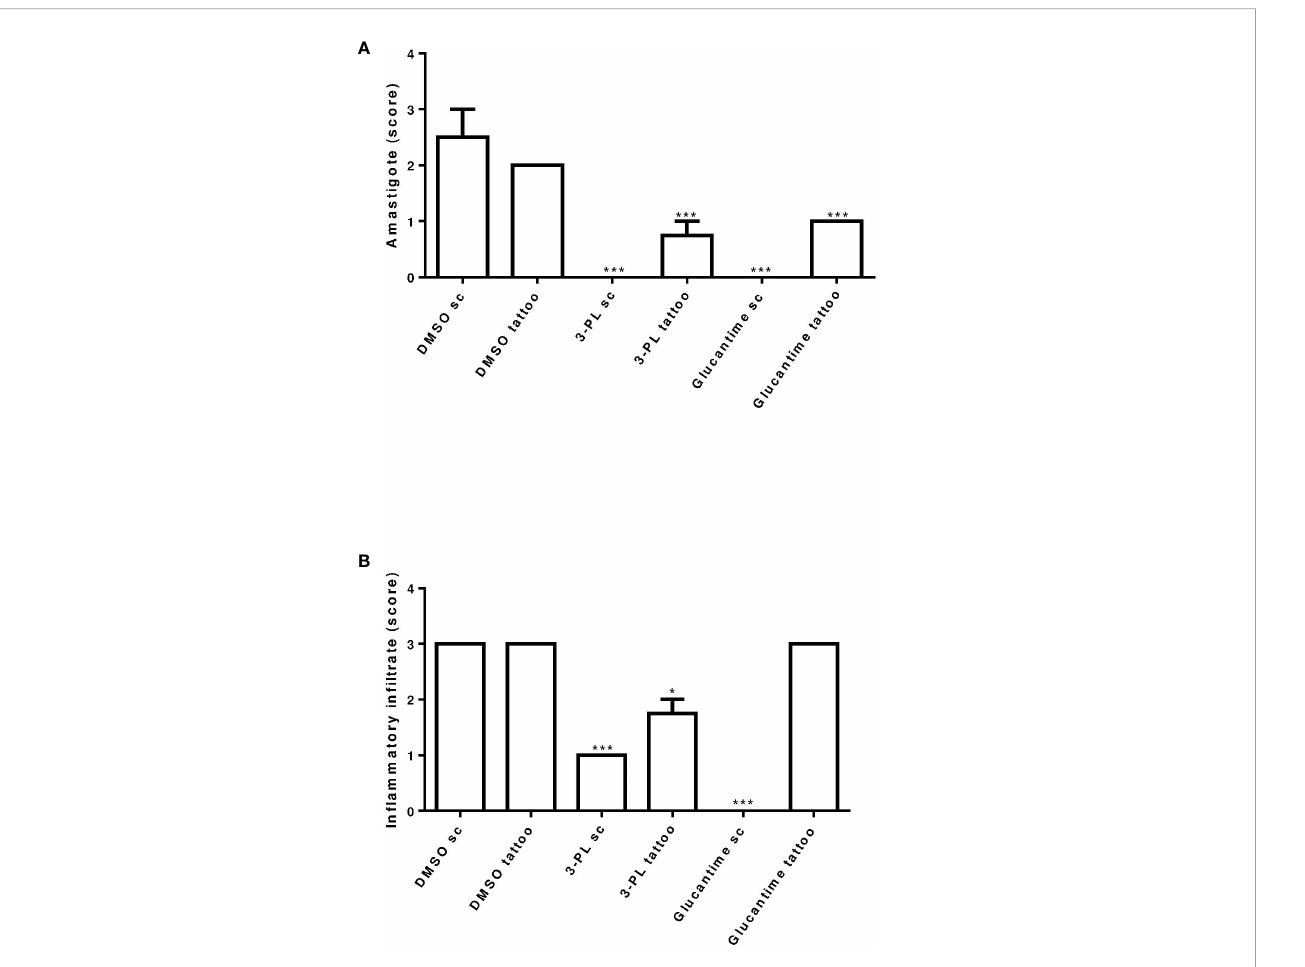
FIGURE 6 Semi-quantitative analysis of histopathological aspects of hamster skin lesions. Skin lesion sections of hamsters infected with L. ( V. ) braziliensis treated or not (as indicated) from 7 days of infection for two weeks were stained with H&E and analyzed under light microscopy. In (A) presence of amastigote and in (B) presence of in fl ammatory in fi ltrate. Results were expressed by scoring. The score value was determined as not observed (score = 0), little observed (score = 1), moderately observed (score = 2) and highly observed (score = 3). **p < 0.01 and ***p < 0.001 in relation to respective DMSO control group (sc or tattoo route). *p ≤